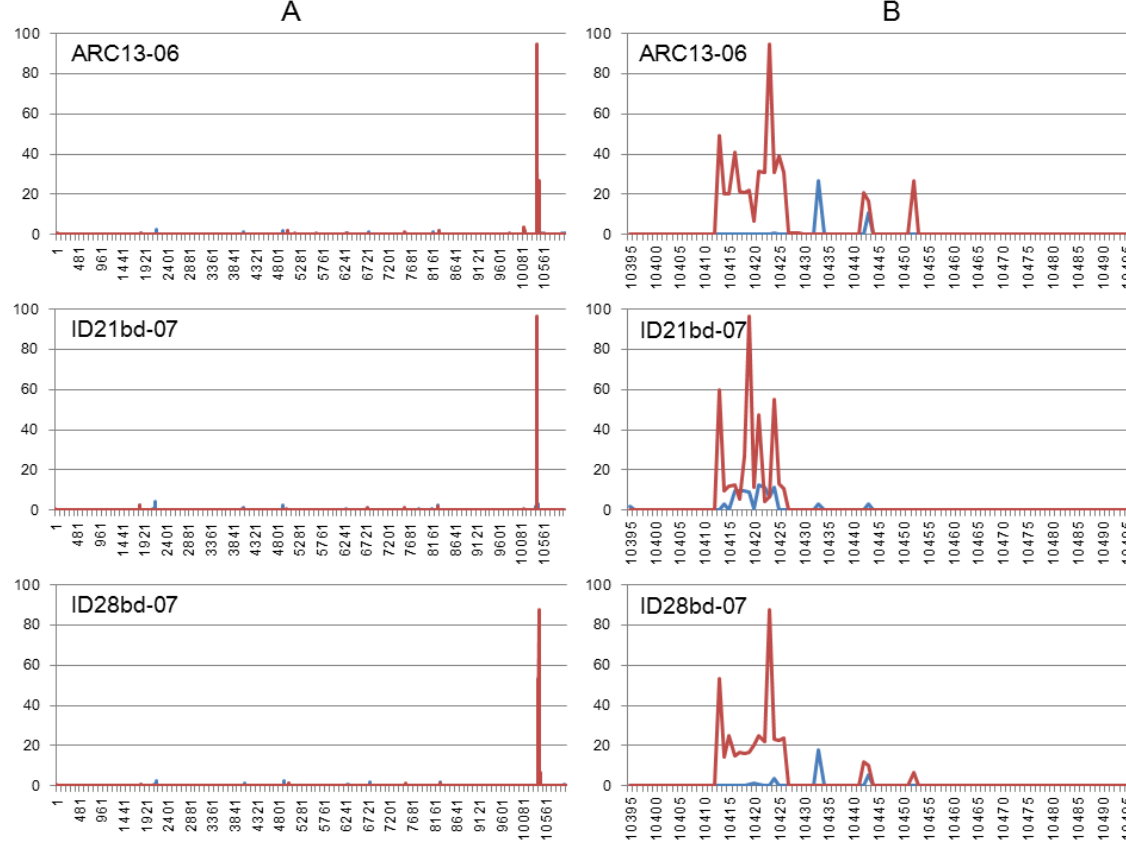
Figure 4. Indel profiles generated by HIVE. Y—percent of mutations; X—nucleotide number. ( A ) Indel profile of the complete genome; ( B ) Indel profile of the variable region of the 3 ′ UTR. Deletions are shown in red, insertions in